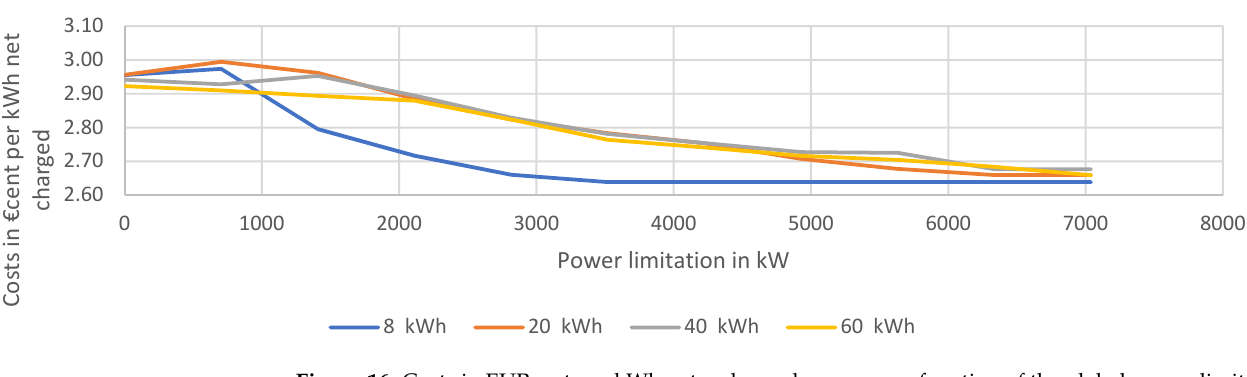
Figure 16. Costs in EURcent per kWh net recharged energy as a function of the global power limit for the power limits defined in Section 3.2. The left end is the same as “peak minimisation” and the right end is almost identical to the “price optimised” in Figure 15 as a little peak minimisation is required with a power limit of over 7040 kW.